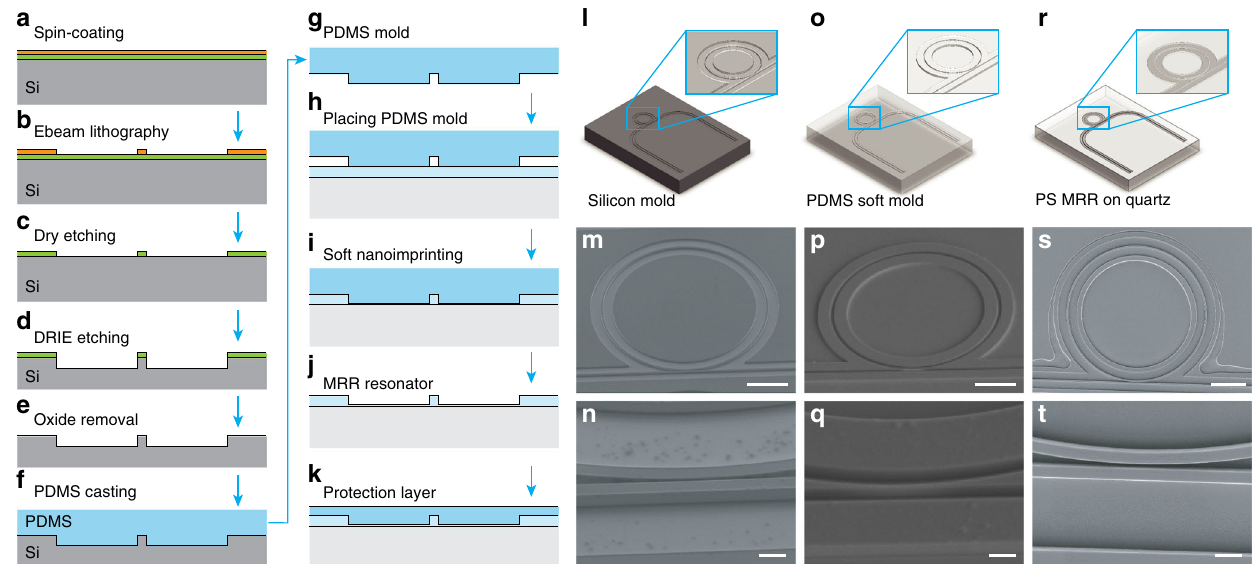
Fig. 2 Fabrication process of the MRR ultrasonic detectors. The fabrication procedure consists of: ( a ) spin-coating of 200 nm photoresist; ( b ) patterning electron beam lithography process; ( c ) RIE pattern transfer from photo-resist into SiO 2 layer; ( d ) DRIE pattern transfer from SiO 2 layer into silicon substrate with high-aspect-ratio features; ( e ) removal of the SiO 2 layer; ( f ) casting the PDMS soft mold via thermal curing of the PDMS precursor; ( g ) peeling off PDMS soft mold from silicon master mold; ( h ) placing PDMS soft mold over a 400-nm-thick PS thin fi lm spin-coated on a quartz coverslip; ( i ) molding process by heating the polystyrene fi lm over its glass transition temperature; ( j ) after cooling down to room temperature, the PDMS stamp is peeled off; fi nally, ( k ) a 5- μ m UV-curable PDMS thin fi lm is spin-coated on the MRR waveguide and then cured by excessive UV exposure. The illustration of ( l ) silicon mold, ( o ) PDMS soft mold, and ( r ) fabricated MRR on quartz substrate and the magni fi ed views shown as inset. The scanning electron microscope images of ( m ) silicon mold, ( p ) PDMS soft mold, and ( s ) MRR device. Their corresponding magni fi ed image are shown as ( n ), ( q ), and ( t ), respectively. Scale bars: ( m , p , s ) 20 μ m, ( n , q , t ) 2 μ